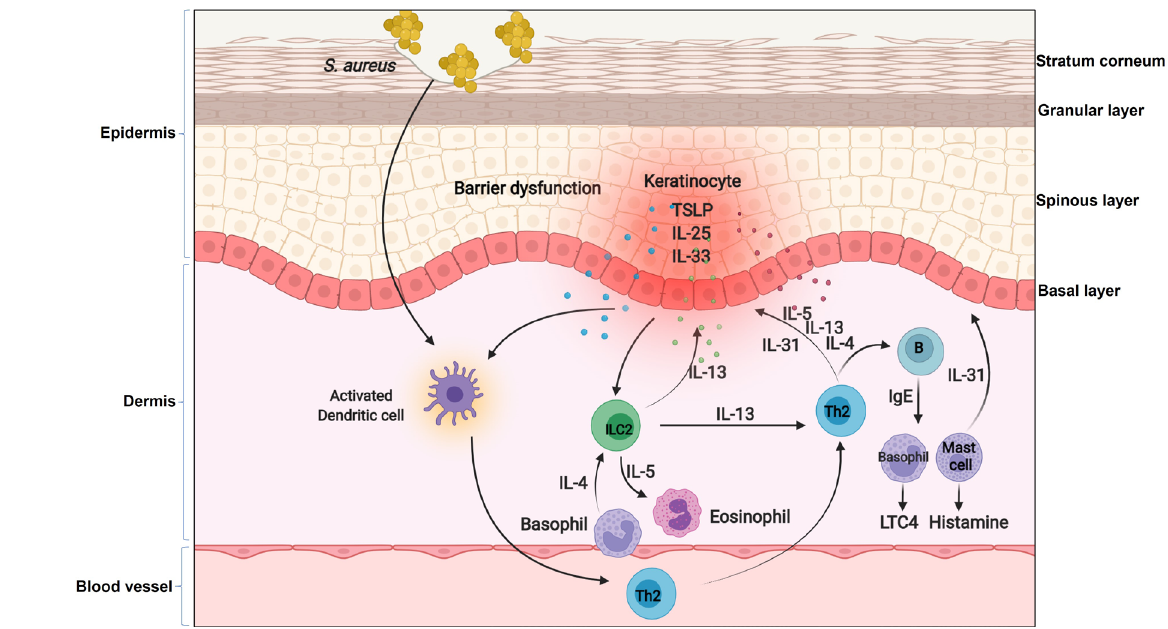
Figure 2. The inflammatory loop in AD. In the context of AD, keratinocytes produce cytokines such as TSLP, IL-25 and IL-33. These cytokines on one hand activate DCs to produce chemokines for recruiting Th2 cells and ILC2 into lesional skin, on the other hand directly active basophils to release IL-4 and then activate ILC2. Th2 cells and ILC2 produce IL-4, IL-5 and IL-13 to induce an immunoglobulin isotype switch to IgE in B cells, and then IgE triggers mast cells and basophils to release a diverse group of biologically active products including histamine and LTC4. Moreover, these Th2 cytokines can inhibit FLG expression in keratinocytes or further induce keratinocytes to produce TSLP. Furthermore, the genetic defects in keratinocytes impair skin barrier and facilitates Staphylococcus aureus ( S. aureus ) entry through the epidermal barrier. Penetrated S. aureus enables them to come direct contact with viable immune cells and enhances the expression of Th2 cytokines such as